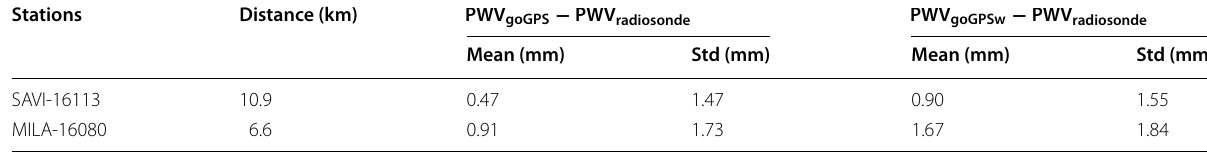
Table 1 Statistics of the differences between the goGPS-derived and radiosonde-derived PWV values